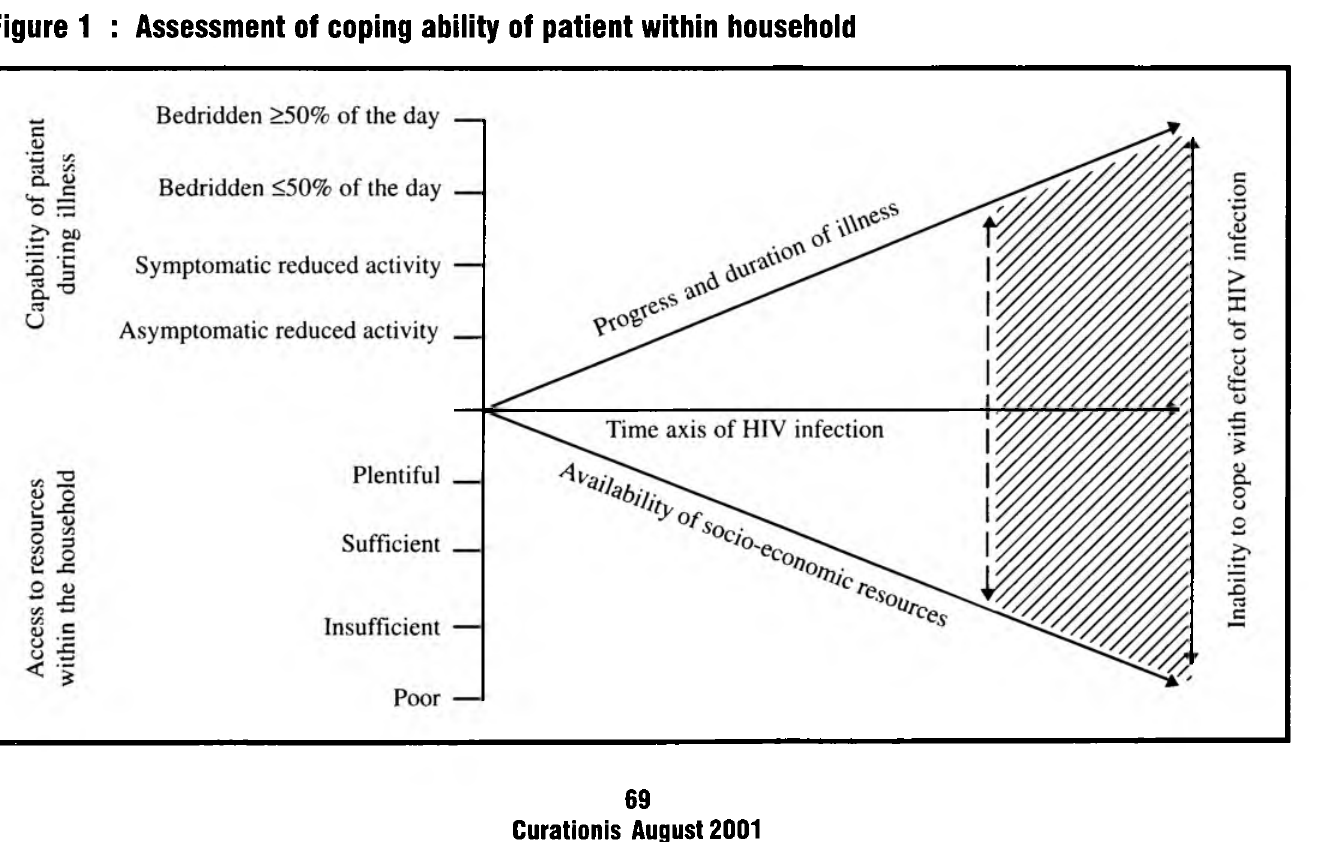
Figure 1 : Assessment of coping ability of patient within